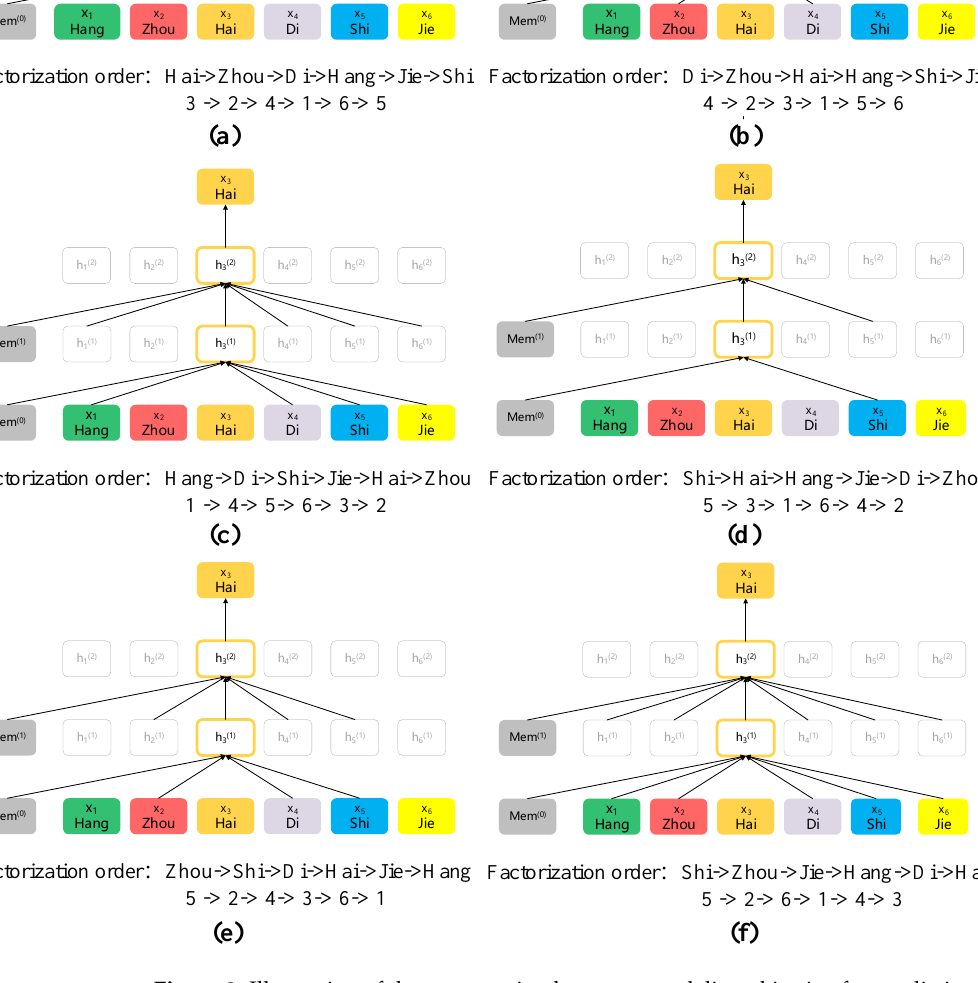
Figure 2. Illustration of the permutation language modeling objective for predicting “Hai” given the same simplified address record but with different factorization orders.